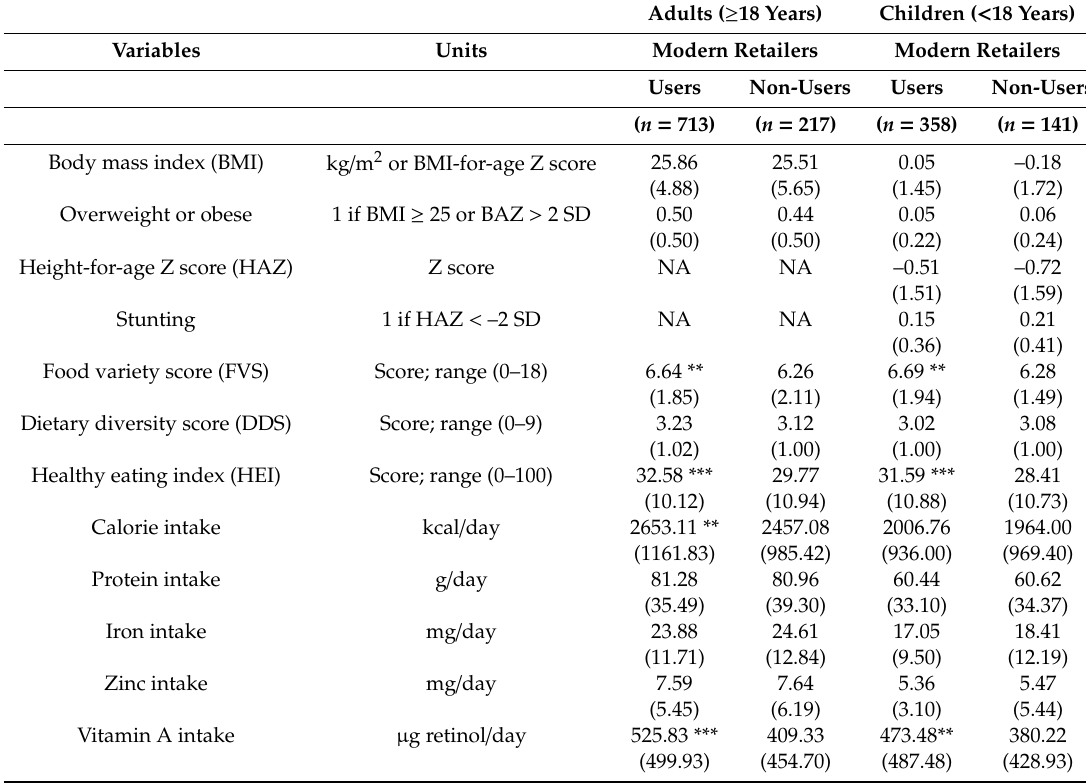
Figure 1. Dietary composition among users and non-users of modern retailers. Average household-level dietary composition is shown in terms of expenditure shares spent on foods at different processing levels. The sample includes 360 households that used and 115 households that did not use modern retailers. Differences in expenditure shares were tested for statistical significance, as shown in Supplementary Table S7. Table 2. Nutrition and dietary indicators for adults and children using and not using modern